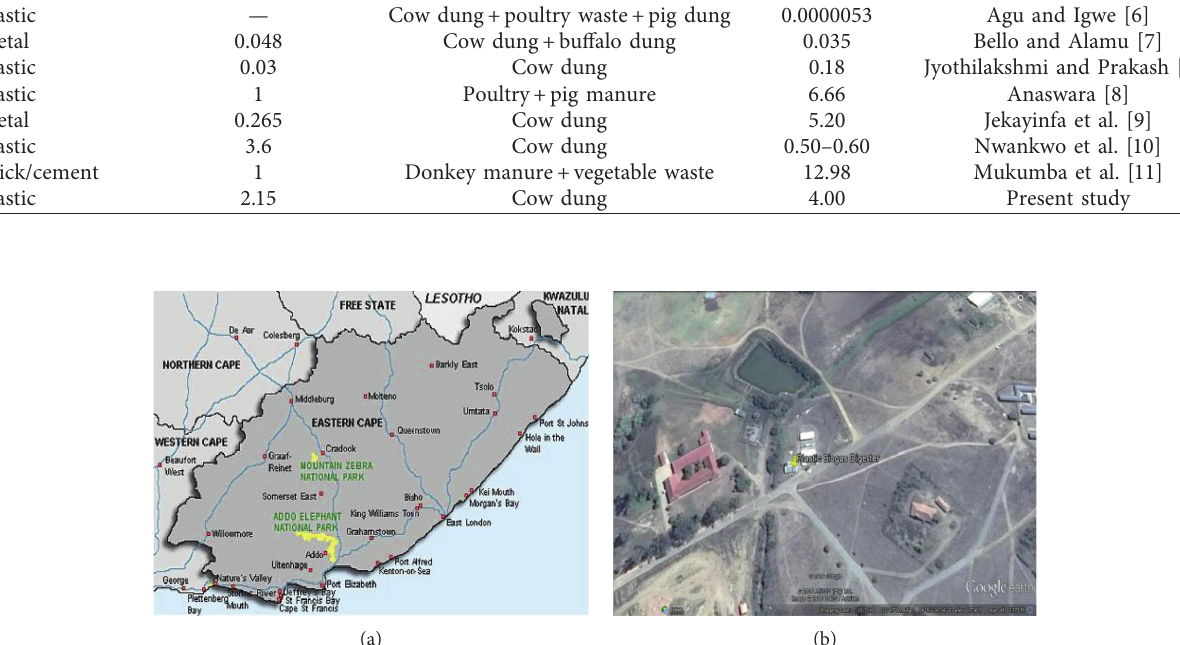
Figure 1: Map showing the Eastern Cape Province of South Africa, and besides, it is the exact location of the study